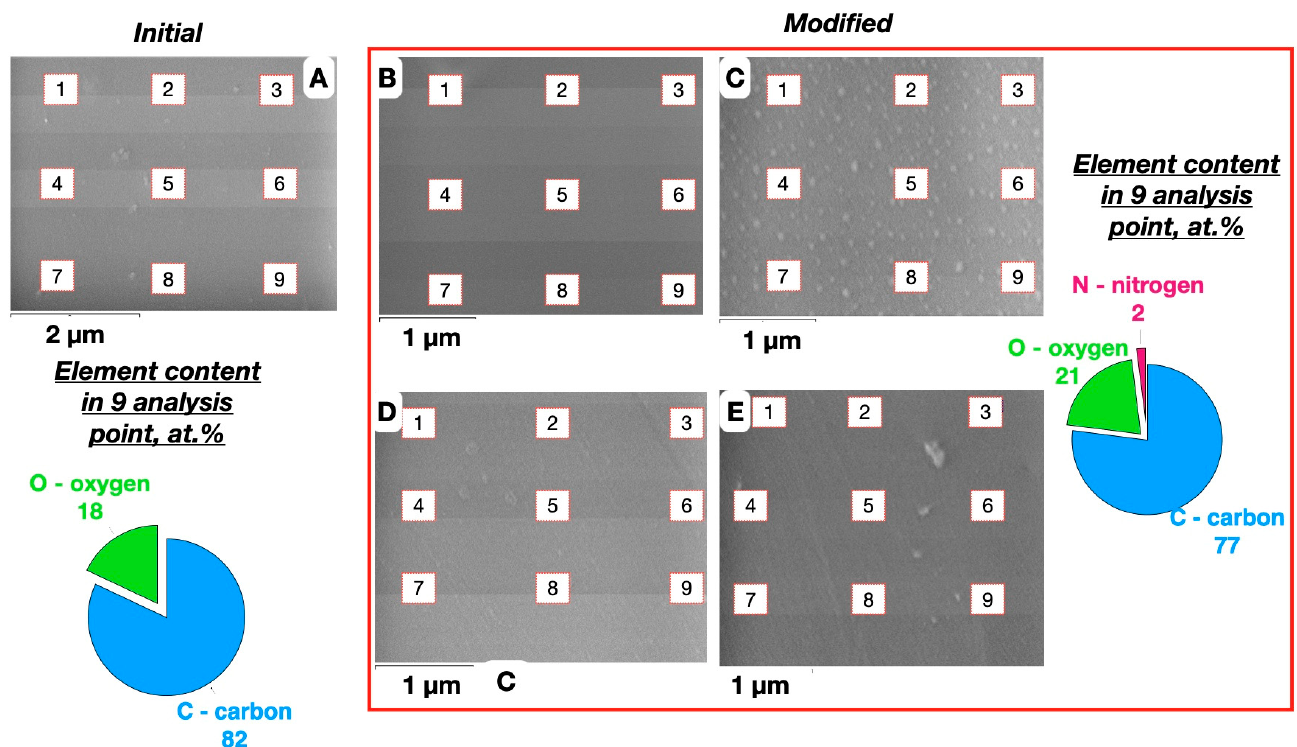
Figure 7. The SEM and EDS analyses (in weight %) of the two micron surface layers of the initial ( A ) and treated 15 s ( B ); 30 s ( С ); 45 s ( D ); and 60 s ( E ) PET-substrates. C—carbon; N—nitrogen; ( A ) and treated 15 s ( B ); 30 s ( C ); 45 s ( D ); and 60 s ( E ) PET-substrates. C—carbon; N—nitrogen; O—oxygen.